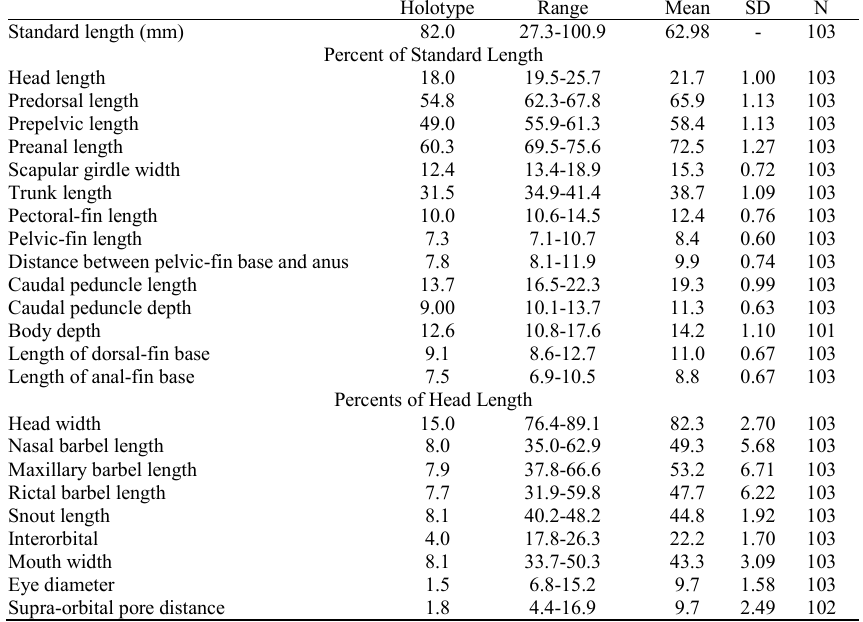
Table 1. Morphometric data for holotype and paratypes of Trichomycterus balios . SD = standard deviation; N = number of